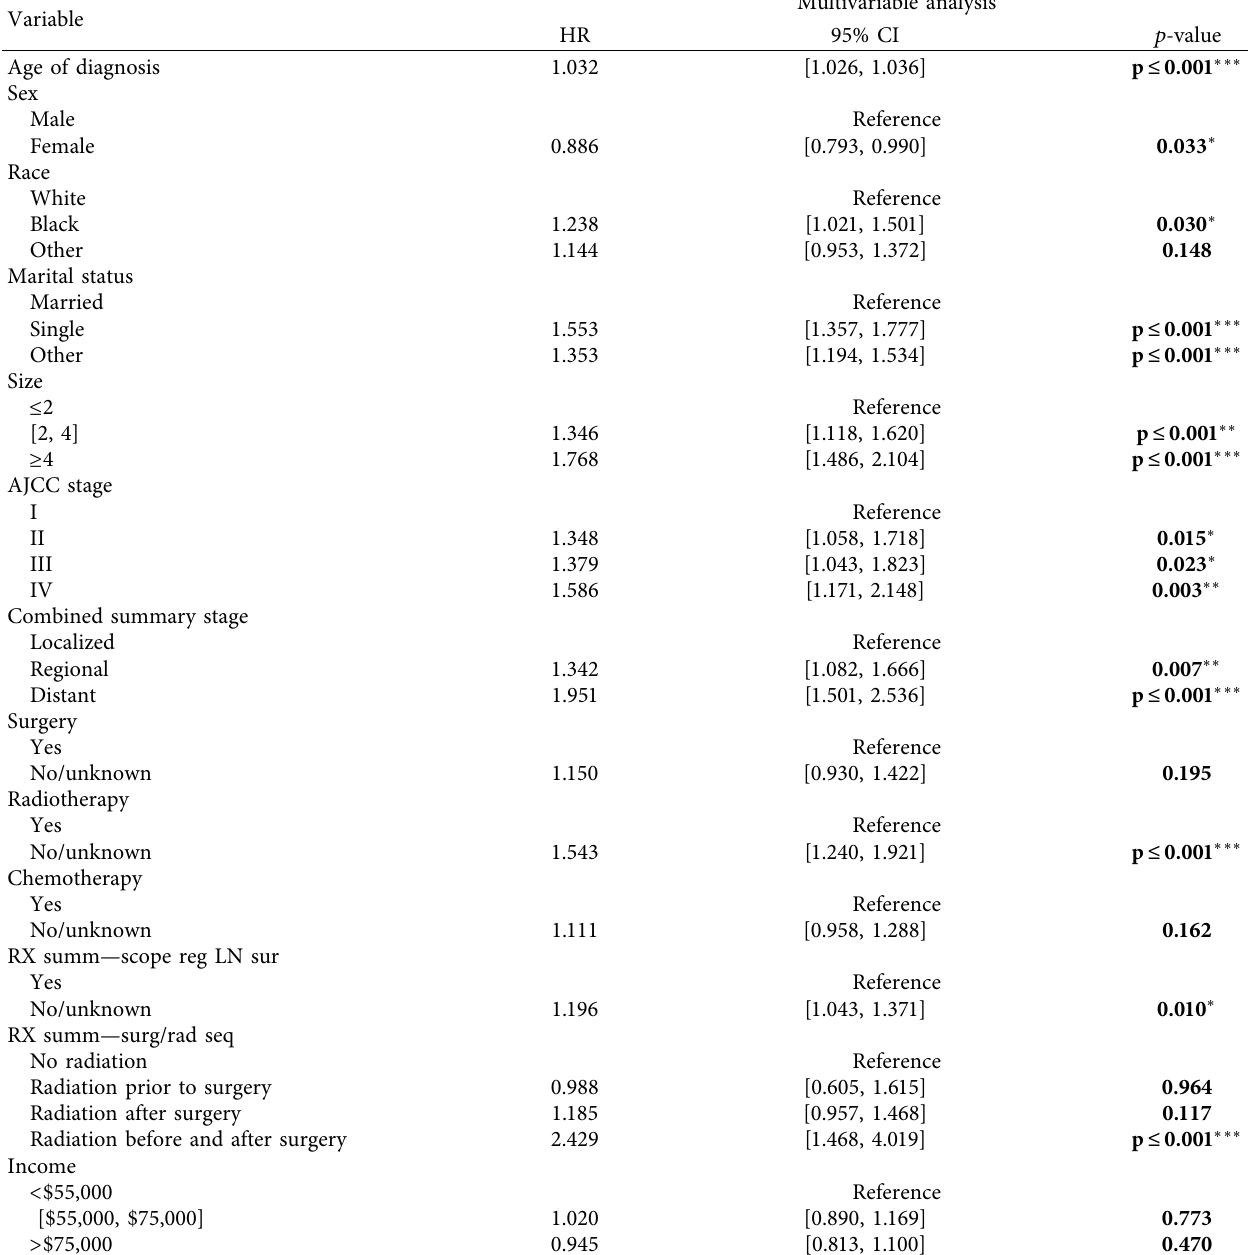
Table 2: Selected variables by multivariable cox regression